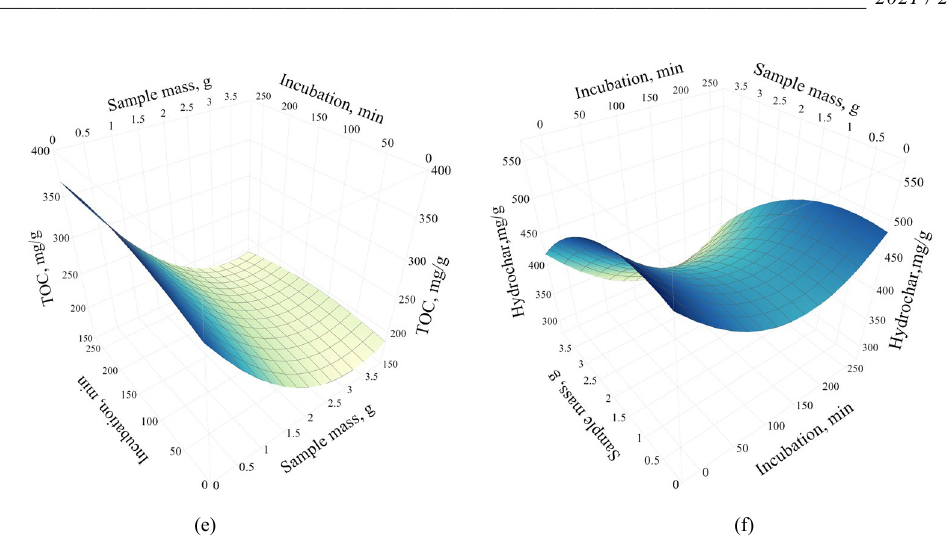
Fig. 1. Impact of the conditions (amount of biomass, treatment time, treatment temperature) of the hydrothermal carbonisation process of the wheat straw on the yield of hydrochar (b, d, f) and artificial humic substances (a, c, e) (expressed as Total Organic Carbon - TOC)